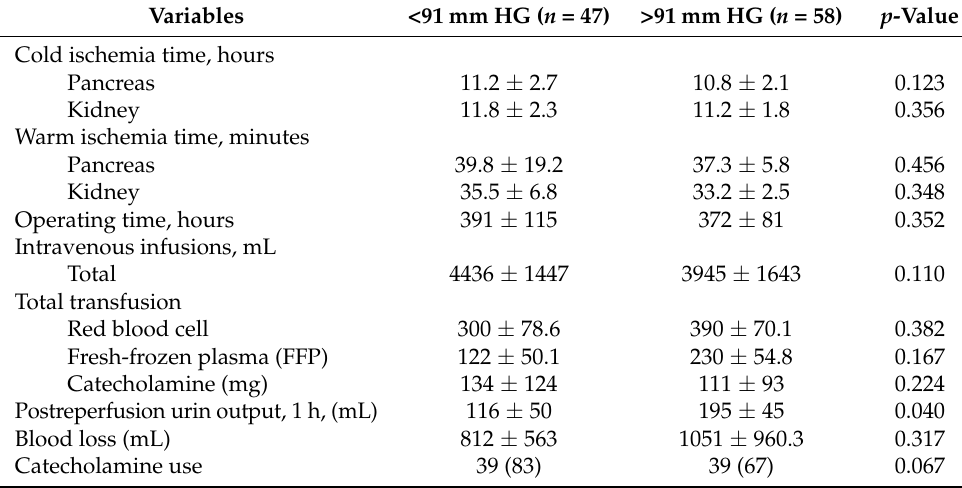
Table 2. Intraoperative outcome and measurements.